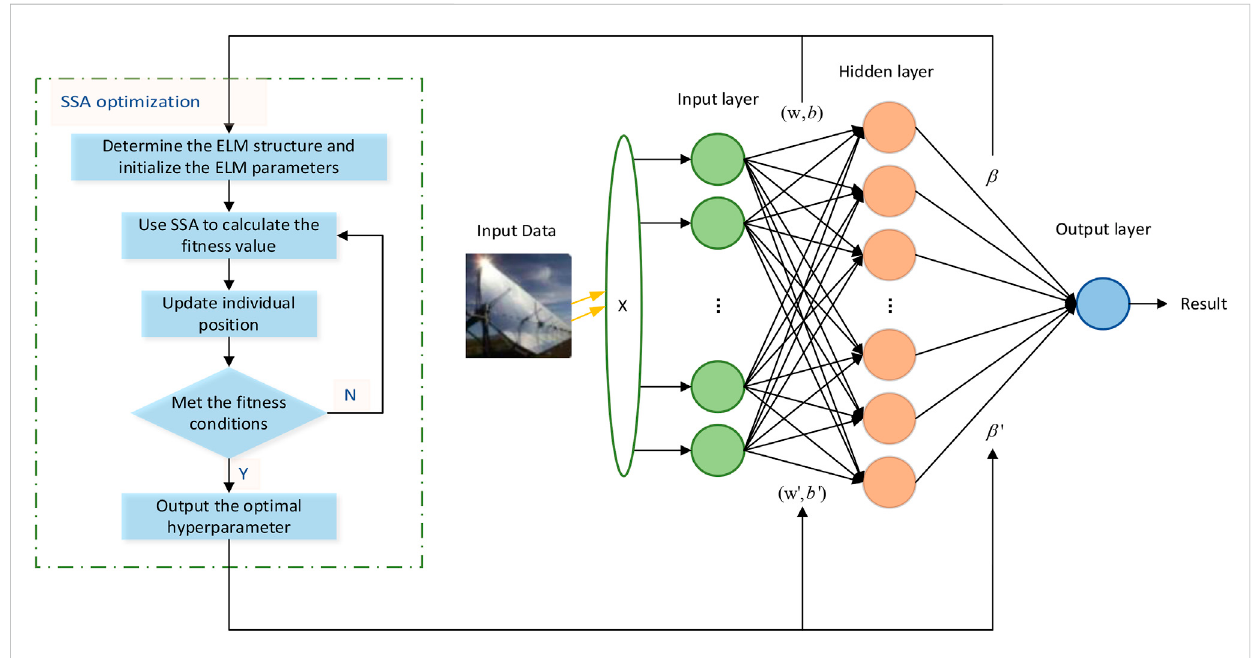
FIGURE 2 SSA-ELM network structure